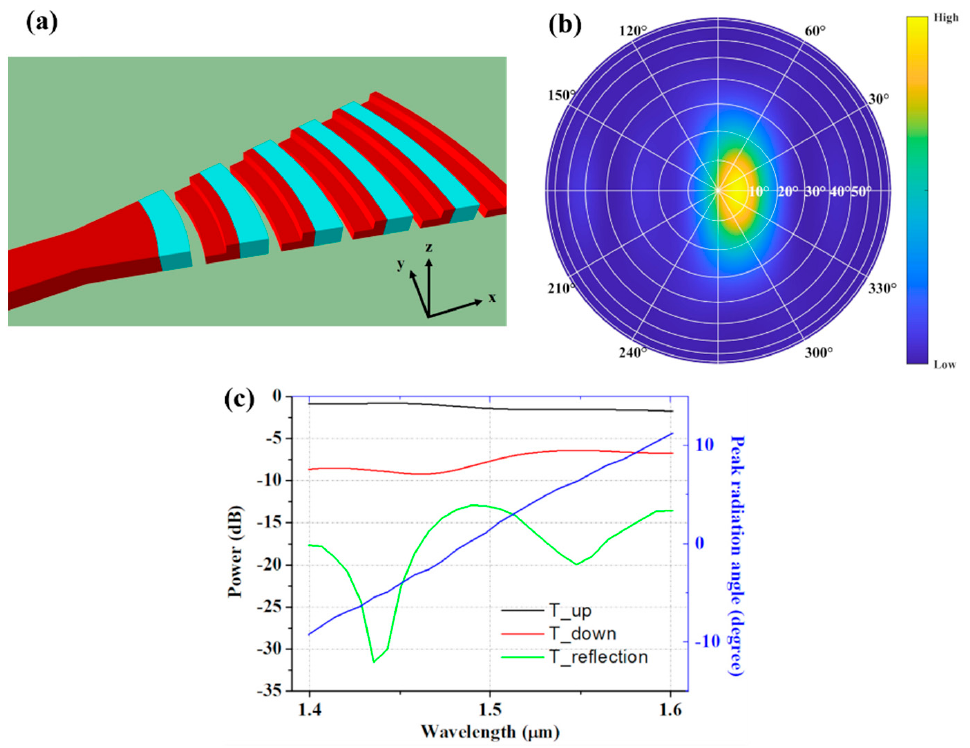
Figure 3. ( a ) 3D schematic of the nano-antenna using Si (red) and the SWG-engineered metamaterial (blue). ( b ) The far-field radiation pattern of the nano-antenna at a wavelength of 1550 nm. ( c ) 3D FDTD simulation of the nano-antenna radiated power (left axis) and peak radiation angle (right axis) as a function of the wavelength.